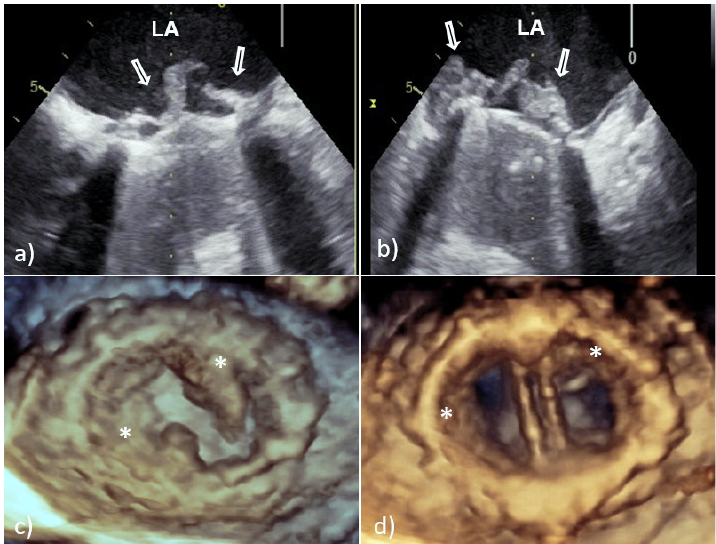
Figure 2. Transesophageal echocardiography of mechanical MVP endocarditis caused with Staphy- lococcus aureus : 2D TEE showed an extensive vegetation (white arrows) attached to the prosthetic ring and leaflets ( a , b ); 3D TEE showed voluminous vegetation (asterisks) affecting a whole circum- ference of sewing ring and MVP leaflets ( c —in systole, d —in diastole). 2D TEE—two-dimensional transesophageal echocardiography; 3D TEE—three-dimensional transesophageal echocardiography; LA—left atrium; PVE—prosthetic valve endocarditis; and MVP—mitral valve prosthesis.